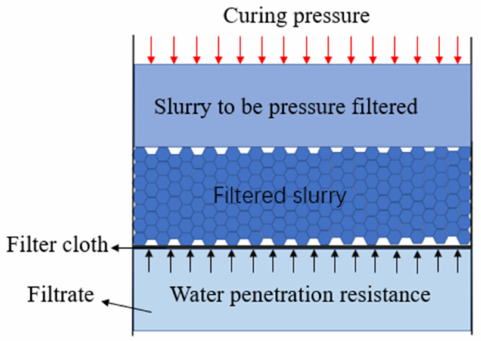
Figure 1. Simple model of double-high curing device.